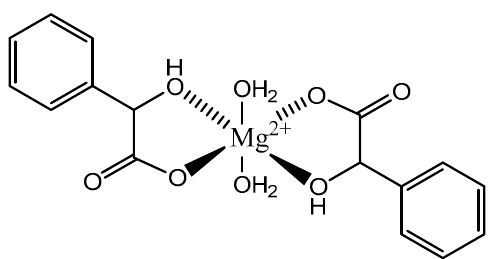
Figure 5. Illustrated structure of mandelic acid .